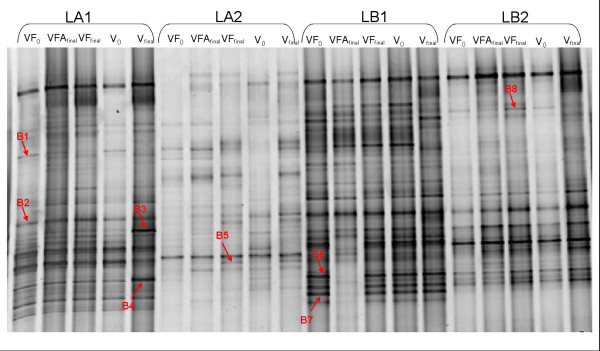
Bacterial community structure at the beginning (referred to as '0') and at the end (96 h, referred as 'final') of the incubation, visualized by DGGE of PCR-amplified partial 16S rRNA genes, and the position of the different bands excised and sequenced. (B1 to B8, see Table 5). V0 and VFinal, treatment Viruses+Bacteria at the beginning and the end of experiments; VF0 and VFfinal, treatment Viruses+Bacteria+Flagellates at the beginning and the end of experiments, VFAfinal, treatment Viruses+Bacteria+Flagellates+Autotrophs at the end of experiments